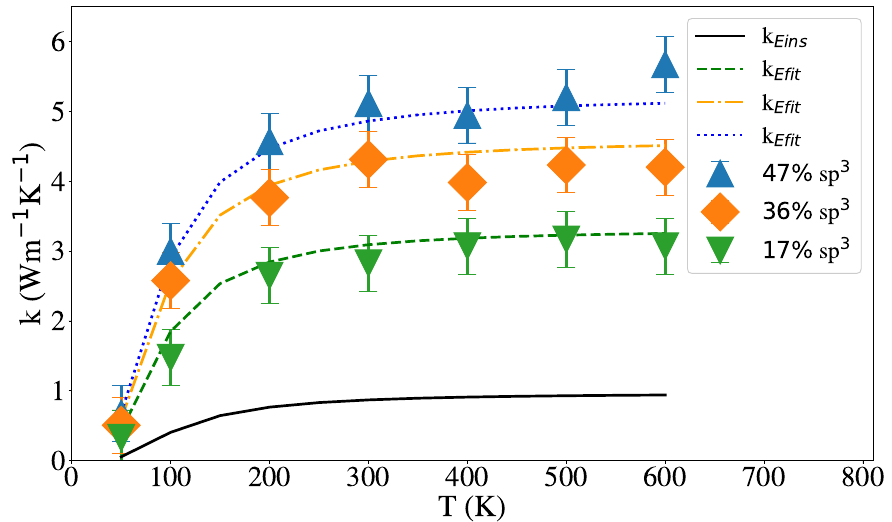
Figure 9. Thermal conductivity vs. temperature for NT with 2 and 1 nm of external and internal radius, for different percent of sp 3 hybridization. The solid line represent the Einstein limit given by Equation (3), the dashed, dash-dotted and dotted lines represent Equation (6) for the NT of 17%, 36% and 47% of sp 3 hybridization, respectively.